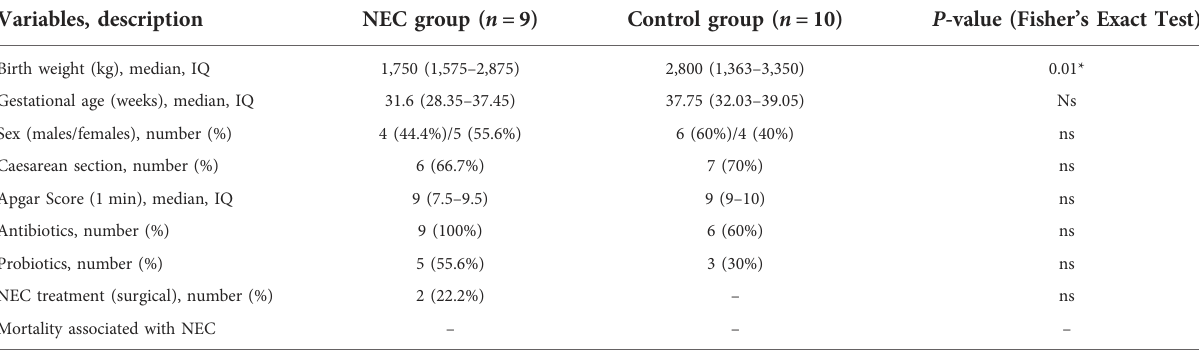
TABLE 1 Participant